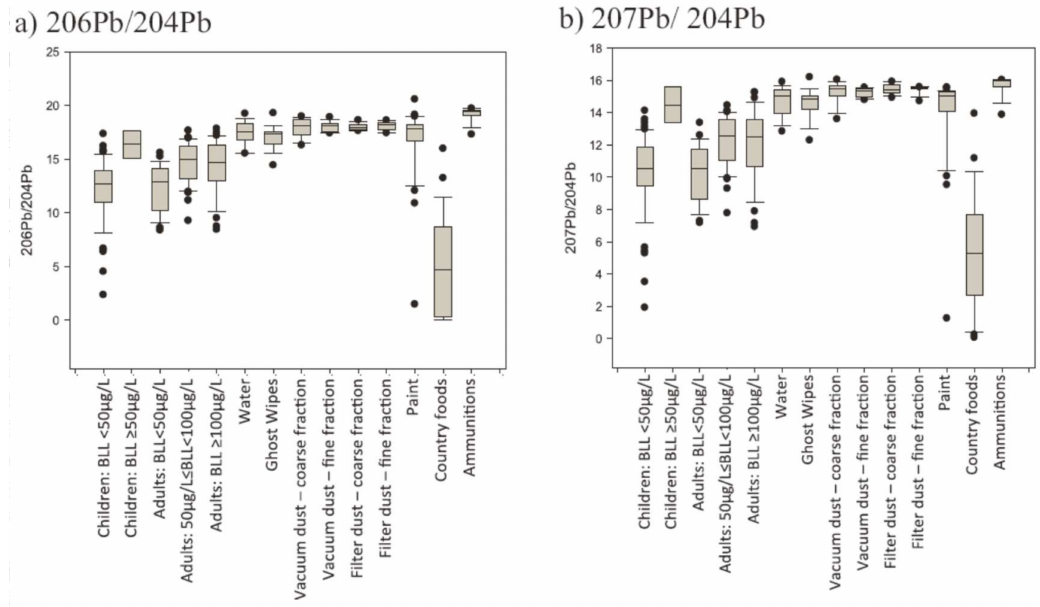
Figure 3. Isotopic ratios in blood and environmental samples from the study of Fillion et al. [28] showing some impossible low 204 Pb-based ratios for terrestrial samples such as some blood samples and the country